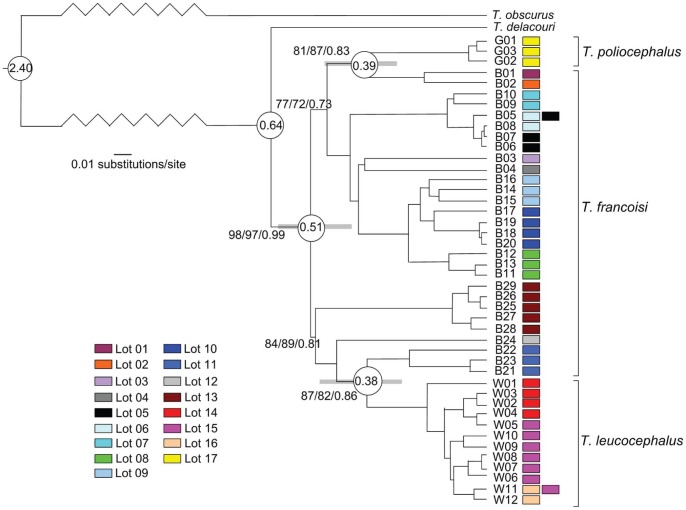
Phylogenetic relationships among T. francoisi, T. leucocephalus and T. poliocephalus haplotypes.Labels refer to haplotype identification numbers (see Table S1). Values above branches indicate support for each node based on ML/MP/Bayesian algorithms, respectively. Bootstrap values <50% are not shown. Divergence age estimates for major nodes are depicted in circles along with their 95% credibility intervals (grey bars). Sampling lots are presented as colored rectangles.